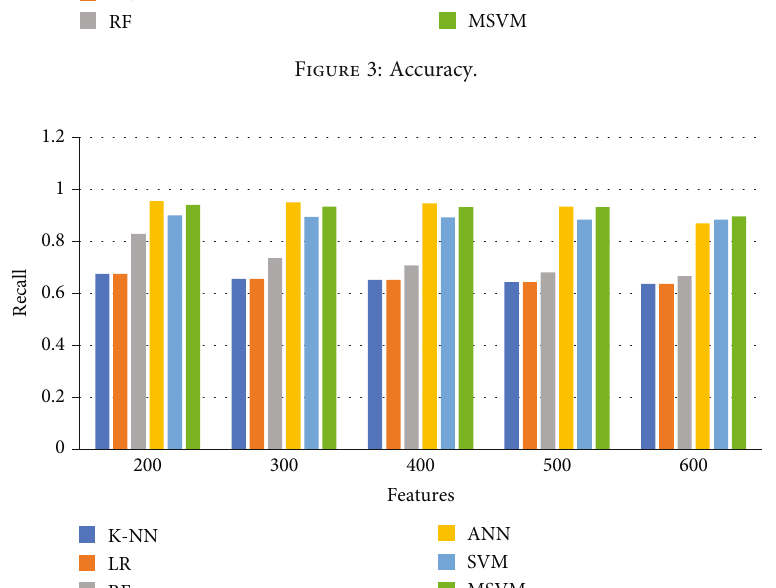
Figure 3: Accuracy.